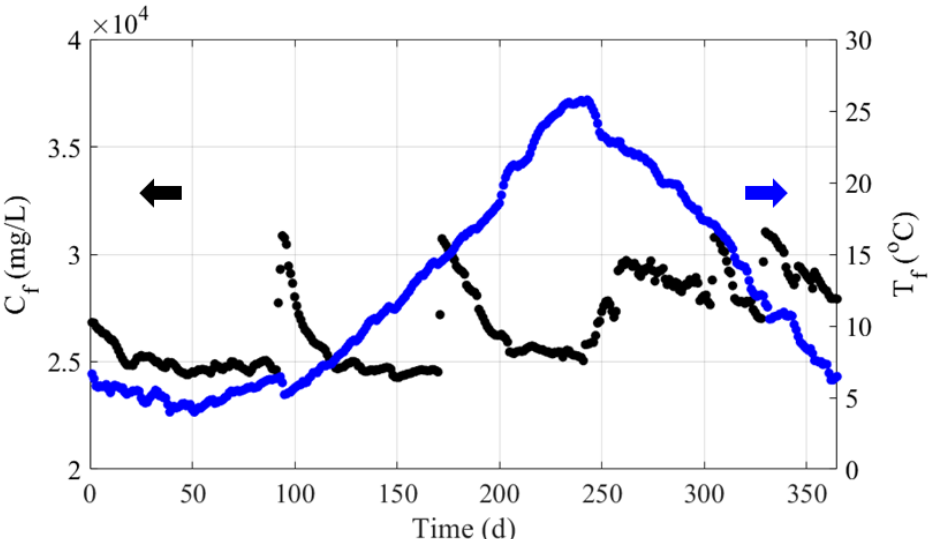
Figure 1. Graphical description of seawater temperature and salinity offshore from Daesan during the studied 365 days of monitoring.